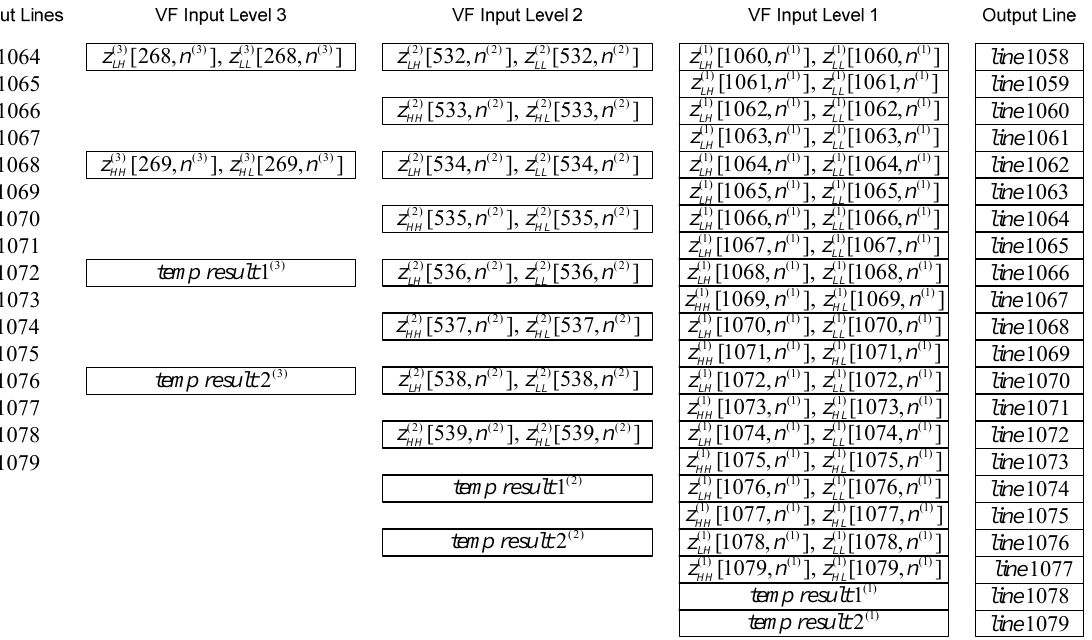
Figure 16. The time diagram of the end of the line ‐ wise filtering.